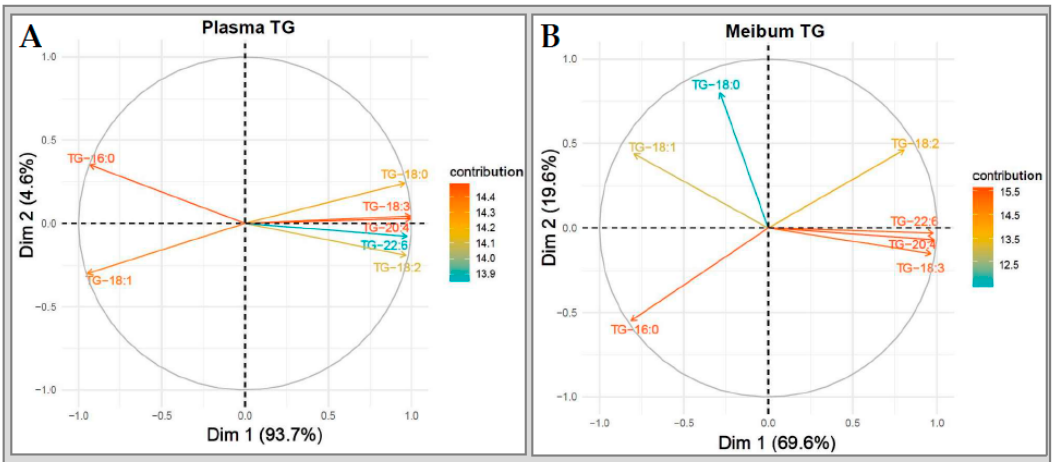
Figure 9. Variable correlation plots of ( A ) plasma TG and ( B ) meibum TG species. Int. J. Mol. Sci. 2020 , 21 , x FOR PEER REVIEW